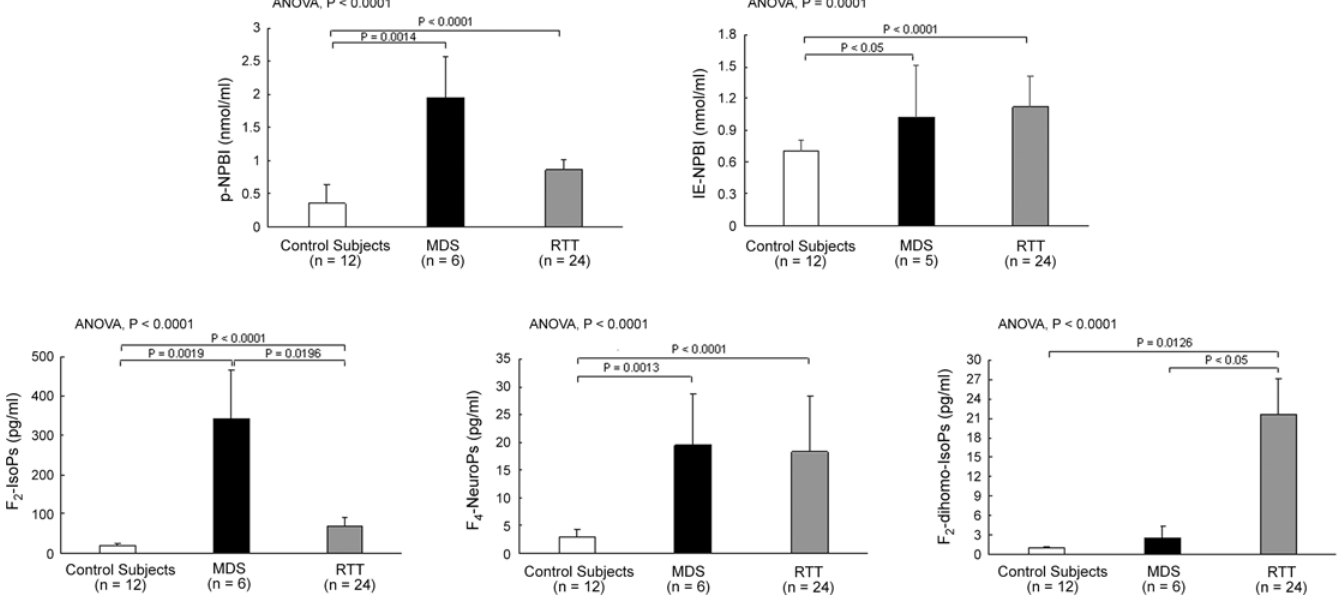
Fig 2. Oxidative stress marker plasma levels in MDS and RTT. Levels of NPBI, plasma free F 2 -IsoPs, F 4 -NeuroPs, and F 2 -dihomo-IsoPs in MDS are compared with those of RTT and healthy control subjects. All the statistical significant differences were reported. Legend: ANOVA, analysis of variance; F 2 - dihomo-isoPs, F 2 -dihomo-isoprostanes; F 2 -IsoPs, F 2 -isoprostanes; F 4 -NeuroPs, F 4 -neuroprostanes; IE-NPBI, intraerythrocyte non protein bound iron; MDS, MECP2 Duplication Syndrome; p-NPBI, plasma non protein bound; RTT, Rett syndrome.